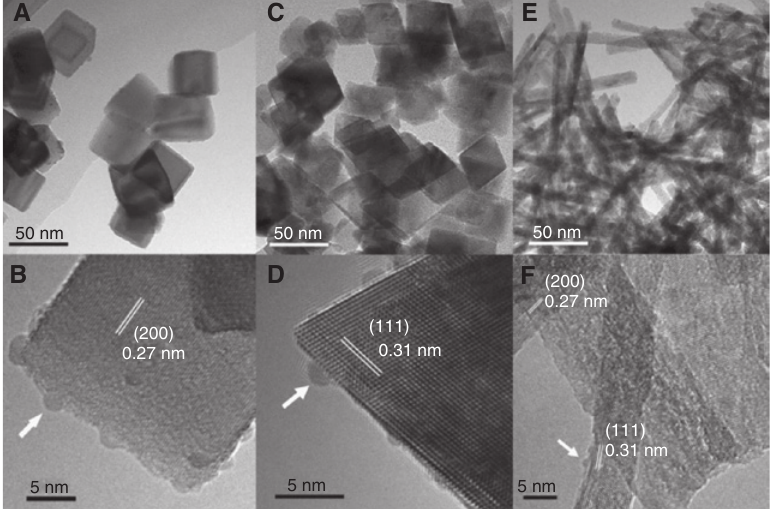
Figure 14: HRTEM images of (A, B) Pd/Cube, (C, D) Pd/Oct, (E, F) Pd/Rod with low and high resolution, respectively. Reproduced from [78] with permission from the American Chemical Society.